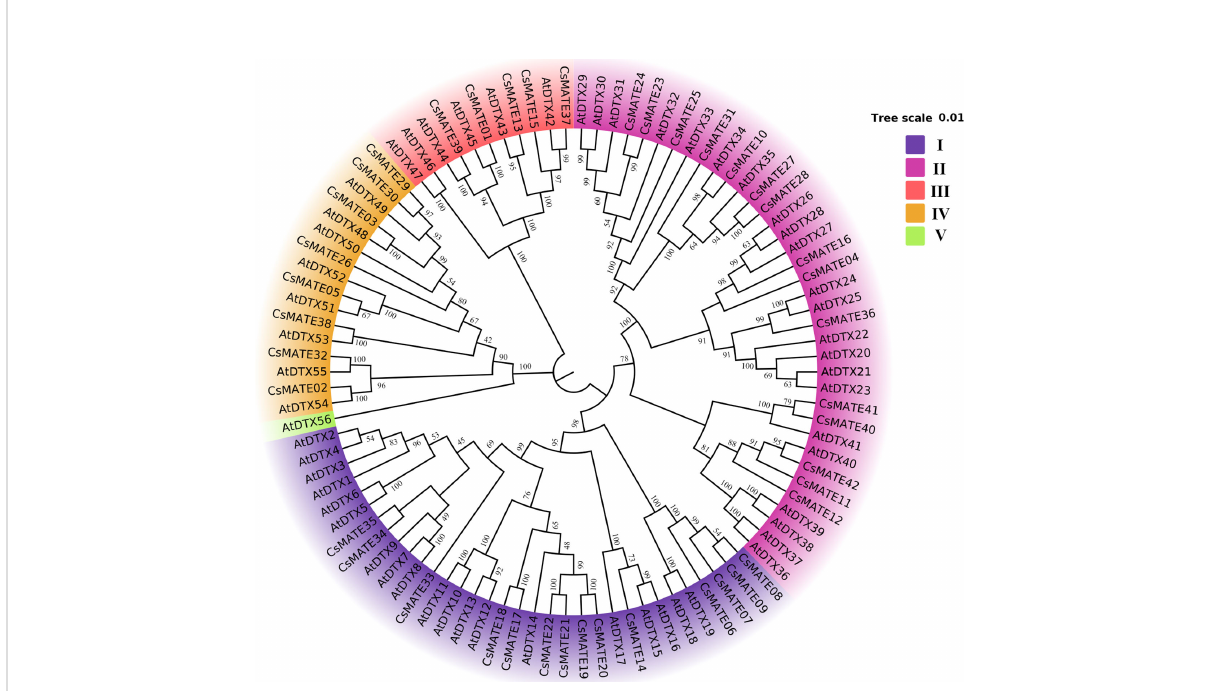
FIGURE 2 Phylogenic tree of MATE proteins in Cannabis sativa (CsMATEs) and Arabidopsis thaliana (AtDTXs). Phylogenic tree was built using MEGA 7.0 software neighbor-joining method (Kumar et al., 2016) with a bootstrap analysis of 1000